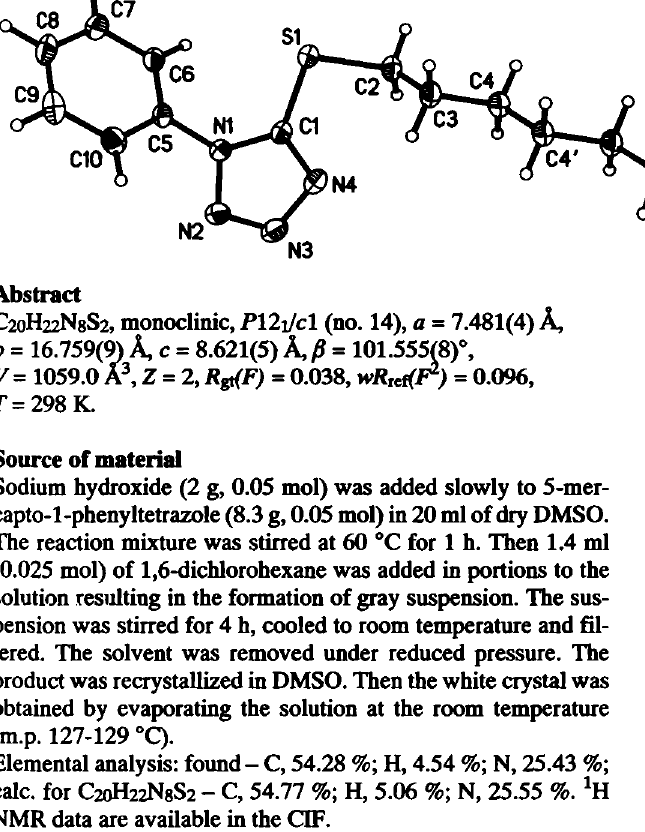
Table 1. Data collection and handling.